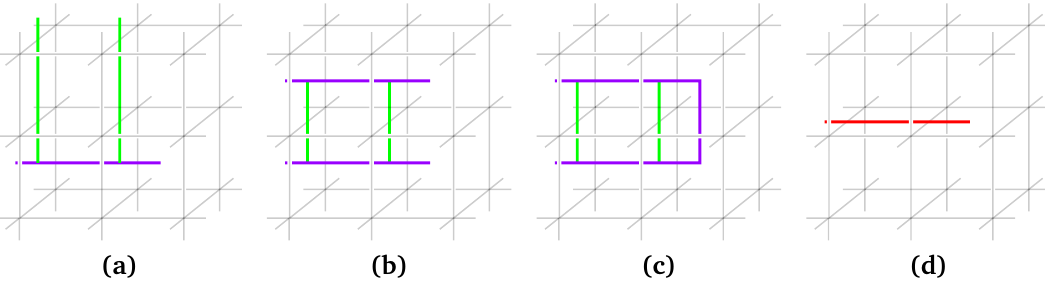
Figure 8: (a) An open string (dual to the membranes), which corresponds to a fracton excitation. (b) A fracton diople given by two fractons seperated by a plane. It is mobile in the plane orthogonal to the green strings and is therefore a planon. (c) A fracton dipole that differs from (b) by only local excitations. (d) A planon given by an open string in a 2D plane. This is an equivalent excitation to (c) since both break the constraint that a plaquette can be penetrated by a purple string if and only if a red, green, or blue string ends at the